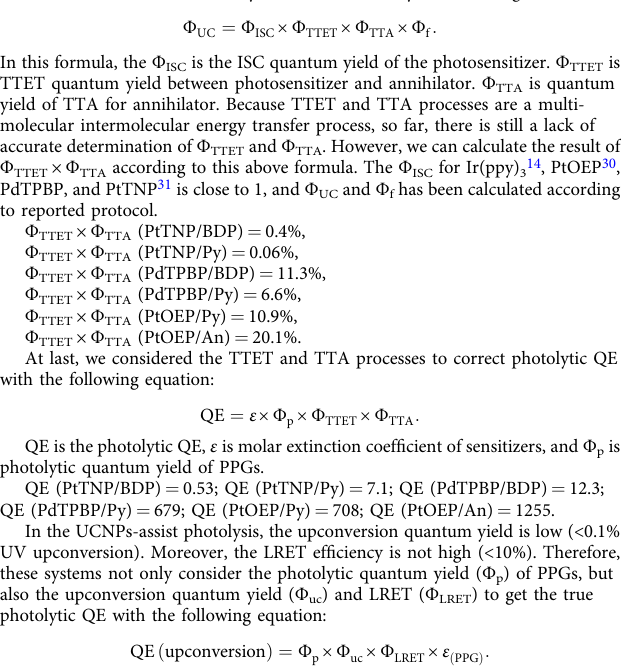
Fig. 3 TTAP NPs-mediated synergistic immunotherapy. a A schematic illustration of the in vivo study of TTAP NPs-mediated prodrug photoactivation with checkpoint blockade the α -PD-L1 antibody to realize synergistic immunotherapy in a bilateral model of 4T1 tumor-bearing BALB/c mice. The right-side tumor stands for primary tumor meanwhile the left side tumor stands for distant tumor or “ metastatic tumor ” . b A schematic illustration of the experimental immunotherapy process. At fi rst, the 4T 1 cells were seeded at both right back and left back of mice. When the right-side tumor volume reached to 100 mm 3 , the TTAP NPs was injected into the right-side tumor, which was then illuminated by NIR LED (20 mW cm − 2 , 650 nm). This day was called as Day 1. At Day 7 – 9, the α -PD-L1 was intraperitoneally (i.p.) injected for mice of groups 3 and 6. Finally, the tumor of mice was isolated on Day 15. c The growth curves of primary tumors. d The growth curves of distant tumors. The red arrow stands for i.p. injection α -PD-L1 for groups 3 and 6 at 7th, 8th, and 9th day. e The primary tumor weight of mice. f The distant tumor weight of mice. “ G ” is the abbreviation of group, values are means ± s.e.m. ( n = 5 mice per group). * p < 0.05, ** p < 0.01, and *** p <